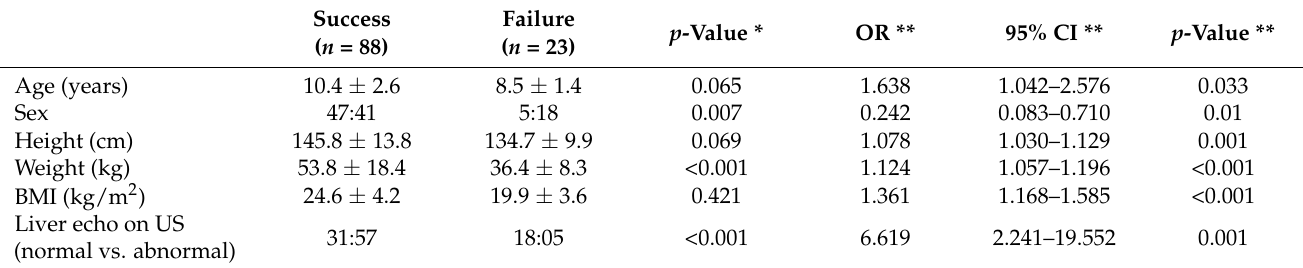
Table 5. Comparison of factors related to measurement failure with